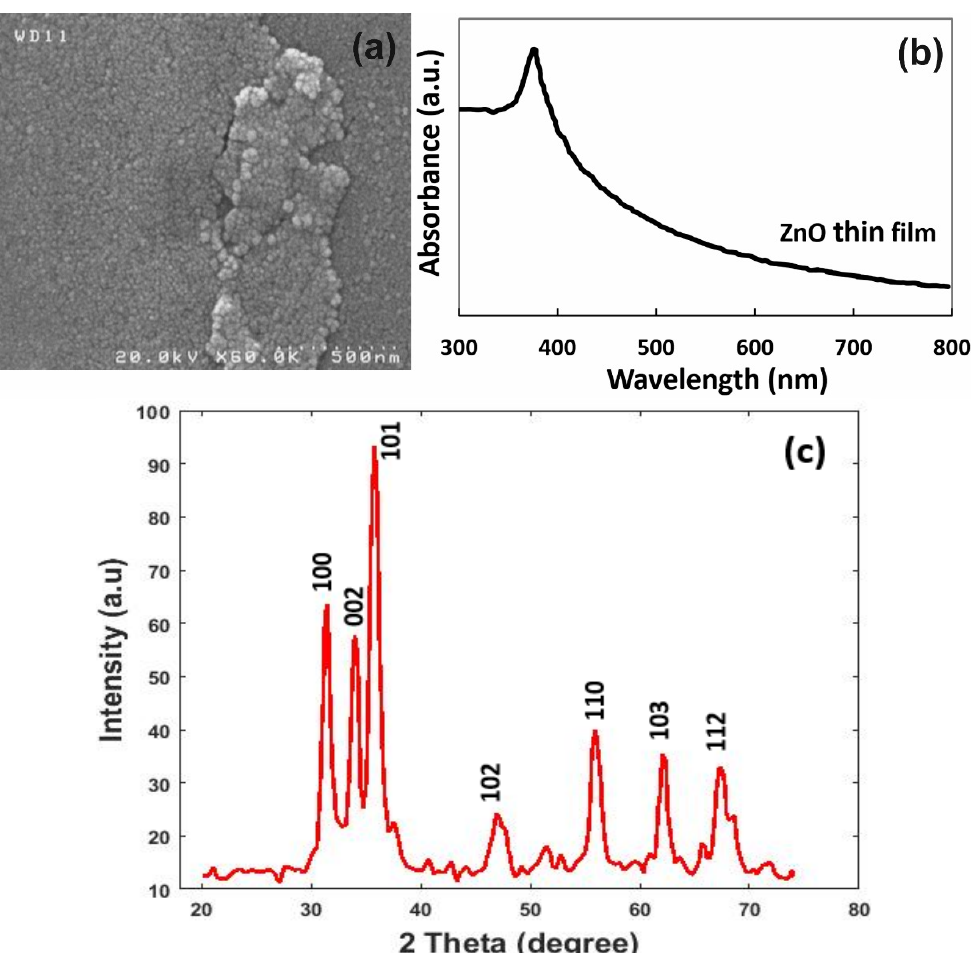
Figure 3. ( a ) SEM of ZnO thin film on the silicon substrate. ( b ) UV-Vis absorption spectrum of ZnO film. ( c ) XRD spectrum of ZnO thin film.